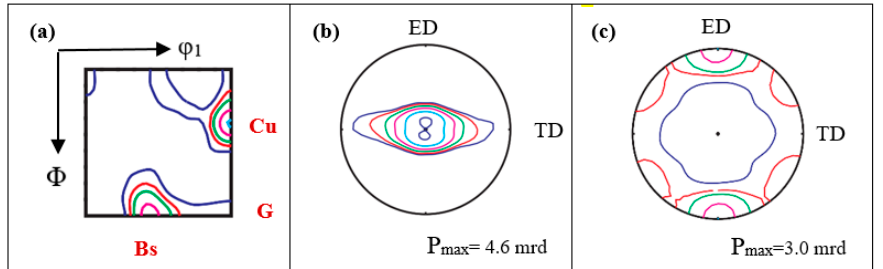
Figure 5. ( a ) Al-texture presented as ODF section ϕ 2 = 45 ◦ and as Mg pole figures. ( b ) (0002) and ( c )